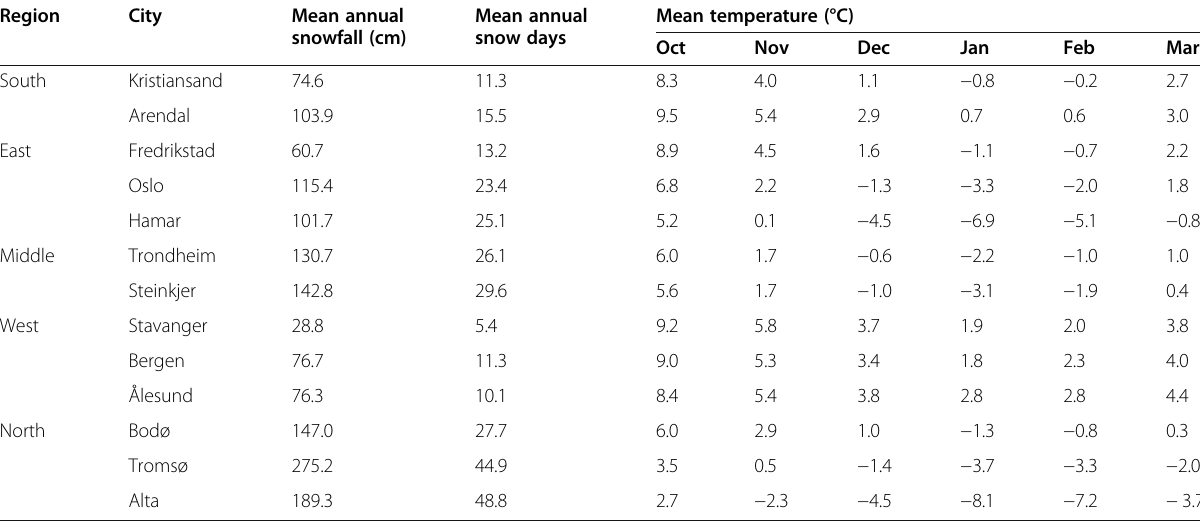
Table 1 Mean annual snowfall, snow days (days with snow precipitation) and mean temperature from October to March for the years 2010 – 2020 for the largest cities in each of Norway ’ s main geographical regions [53] Region